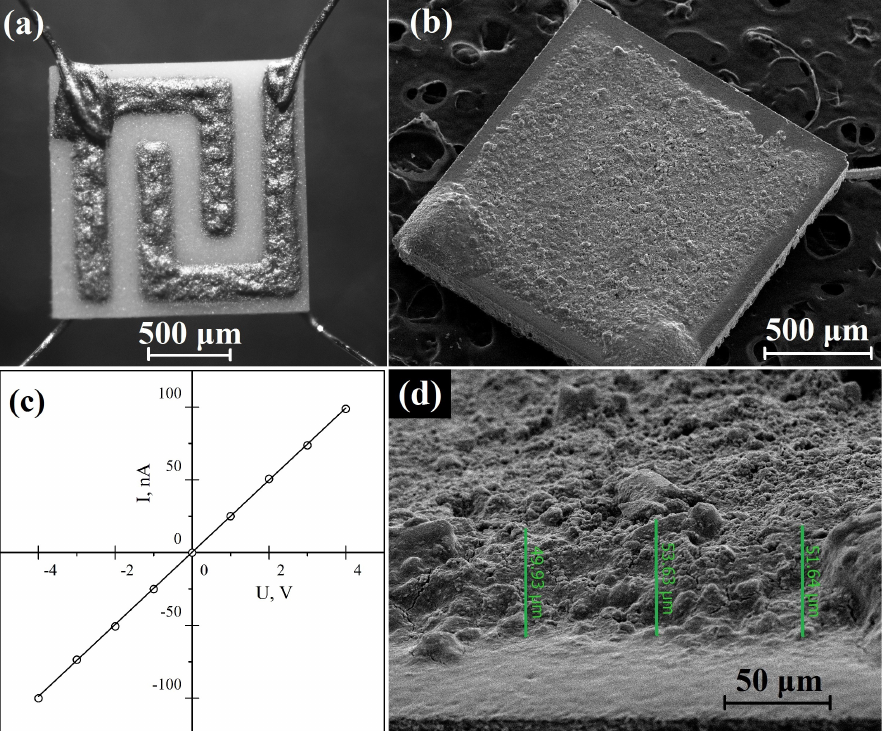
Figure 1. ( a ) Al 2 O 3 measuring plate equipped with two platinum electrodes for measuring the resistance of the sensor layer (image from an optical microscope); ( b ) SEM image of a measuring plate with an applied ZnO layer; ( c ) current–voltage characteristic of ZnO sensor measured at 100 ◦ C in the dark; ( d ) evaluation of the thickness of the applied ZnO layer (SEM image).